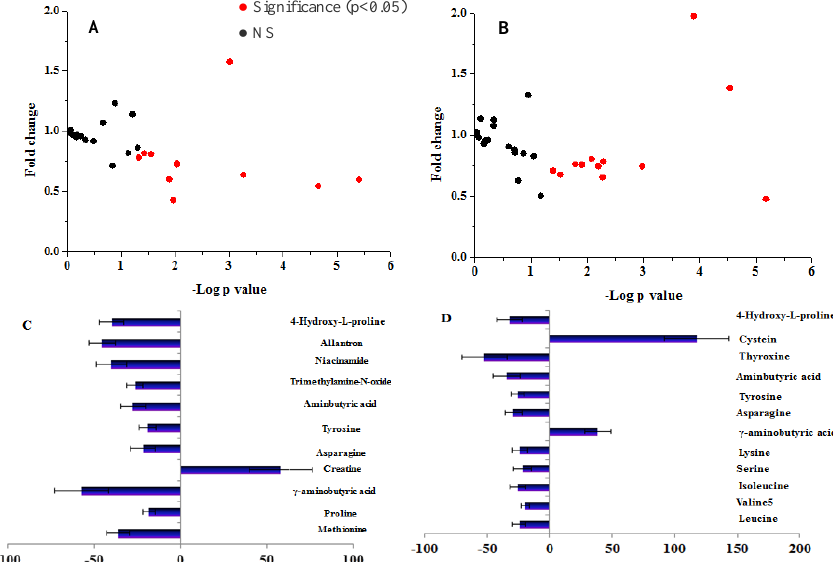
Figure 1. Figure 1. Fold change and significance of metabolite change during an oral glucose challenge in the control ( A ) and the IFG ( B ) groups, and significant percent change of metabolites from fasting to 2-h samples during an OGTT in control ( C ) and the IFG ( D ) groups. Dots represent the 30 metabolites detected in serum. Significant ( p < 0.05) changes Dots represent the 30 metabolites detected in serum. Significant ( p < are colored red. Fold changes and percent changes for the metabolites (X) detected by UPLC-TQ-MS in three loads were calculated as follows: X Fold change = (X Concentration at different 0.05) changes are colored red. Fold changes and percent changes for the metabolites time (30, 60, 90, 120 min) /X Concentration at baseline ); X Percent change = (X Concentration at different time (30, 60, 90, (X) detected by UPLC-TQ-MS in three loads were calculated as follows: X 120 min) − X Concentration at baseline )/(X Concentration at baseline ).